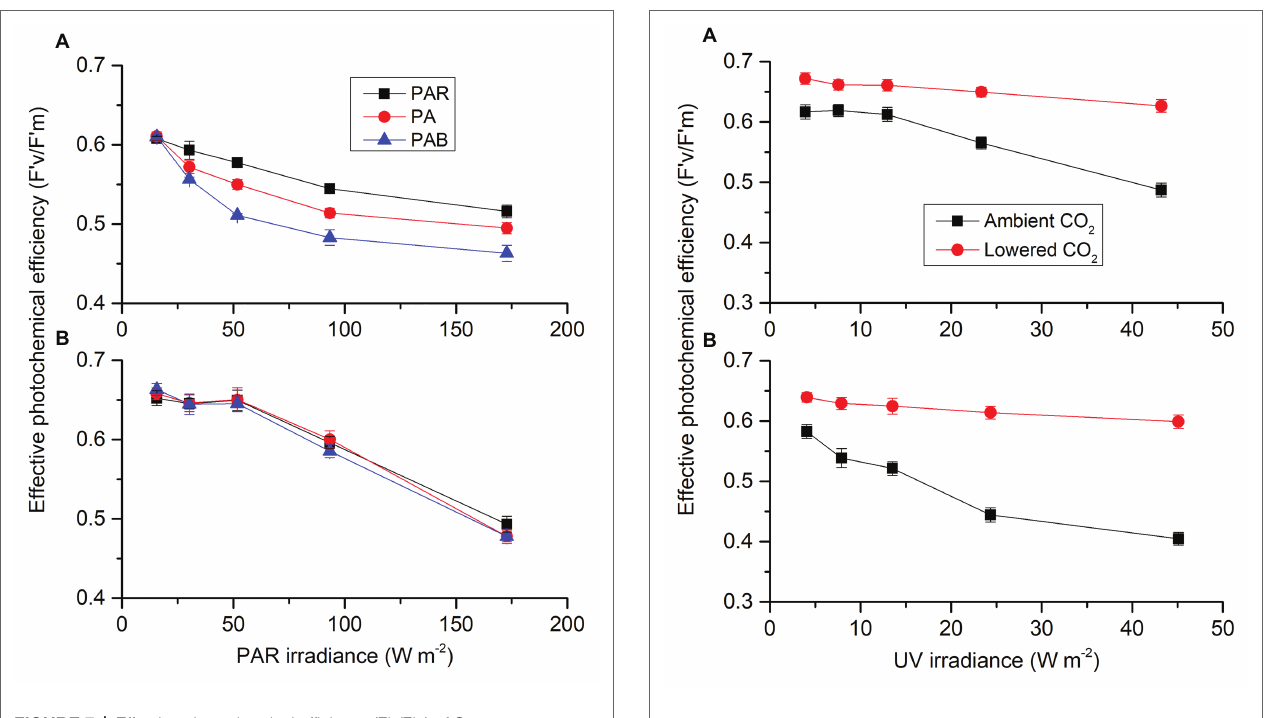
FIGURE 8 | Effective photochemical efficiency (F' v /F' m ) of S. costatum cultured at ambient and lowered CO 2 when exposed to UVA (A) or UVR (UVA + UVB; B ). The error bars indicate the SDs ( n =